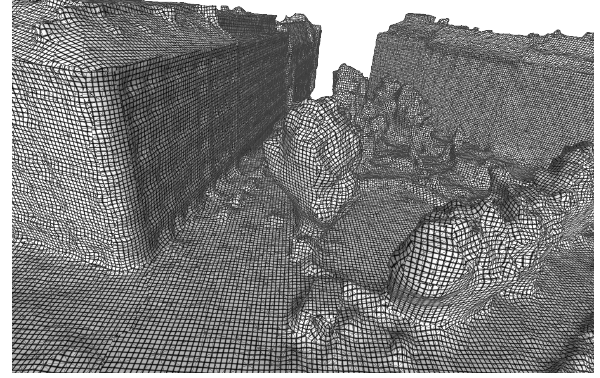
Figure 1. Texture grid on the